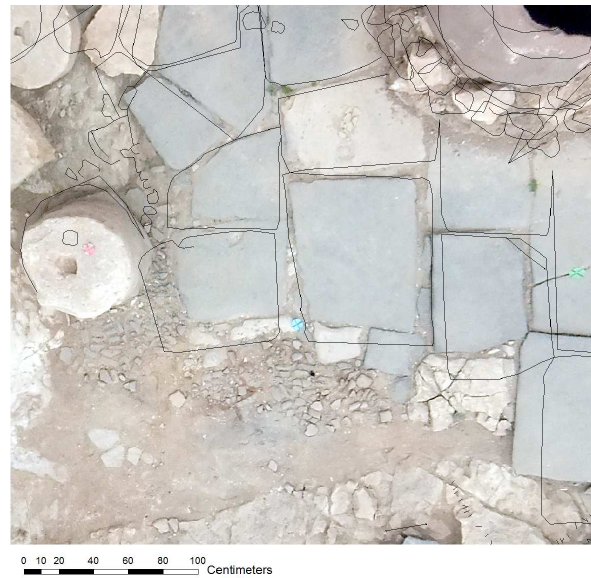
Figure 6. Detail of an orthophoto with overlaid drawings. Flight altitude was approx. 12m; the photo reveals an offset of up to 20cm.